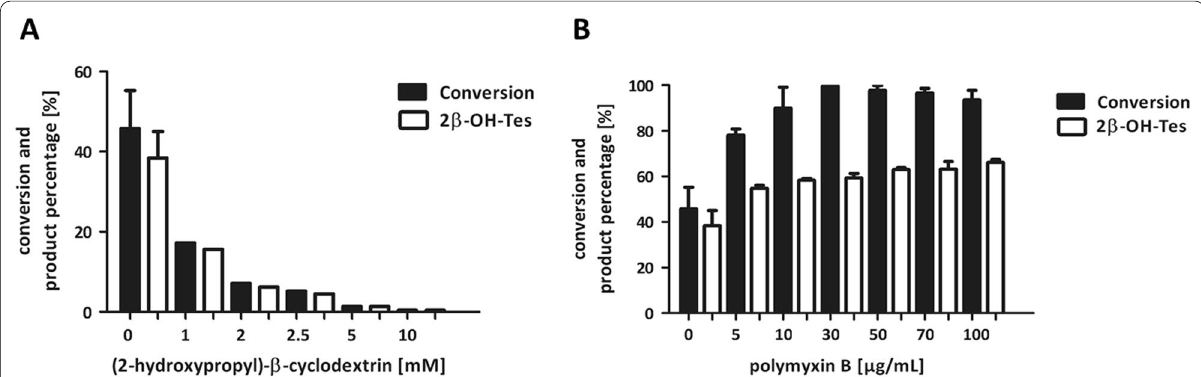
Fig. 4 Conversion of testosterone 1 and formation of 2β-hydroxytestosterone 2 (2β-OH-Tes) by E. coli C43 (DE3) pET22b- cyp105D pCOLADuet- pdx - pdr in presence of different concentrations of (2-hydroxypropyl)-β-cyclodextrin ( A ) or polymyxin B ( B ). Reaction conditions: 50 mg/mL wet cells in 0.5 mL Phosphate Sucrose EDTA (PSE)-buffer with 1 1 dissolved in 5% (v/v) propan-2-ol as final concentration; 25 °C, 1100 min − 1 shaking frequency, reaction time 20 h. Cells were frozen at for preparation of ‘frozen cells.’ (2-hydroxypropyl)-β-cyclodextrin or polymyxin B was additionally added to the best performing wet cell biocatalyst (‘frozen as cell pellet’). All measurements were performed in technical duplicates. In case a standard deviation is given, experiments were additionally conducted in biological